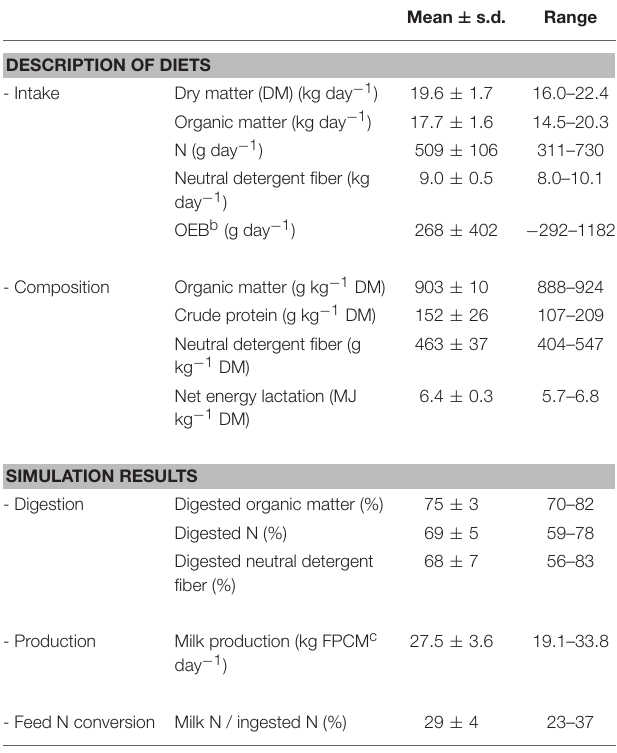
TABLE 4 | Mean values and ranges of intake, diet composition, simulated digestion coefficients, simulated milk production and simulated feed nitrogen (N) conversion of 40 nutritional strategies a for dairy